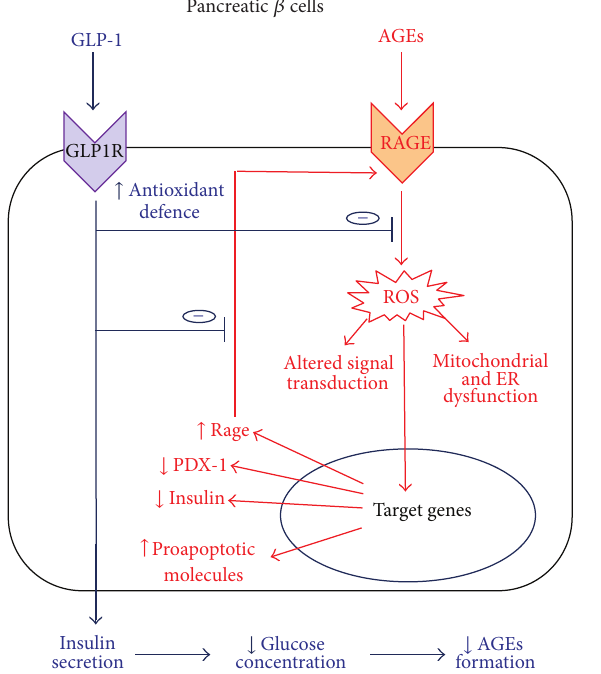
F 2: Bene�cial effects of GLP-1 in other cells exposed to AGEs. Detrimental effect of AGEs leads to cell dysfunction and, eventually, cell death. GLP-1, counteracting AGEs-induced damage with mechanisms reported in pancreatic beta cells, may contribute to reducing diabetic